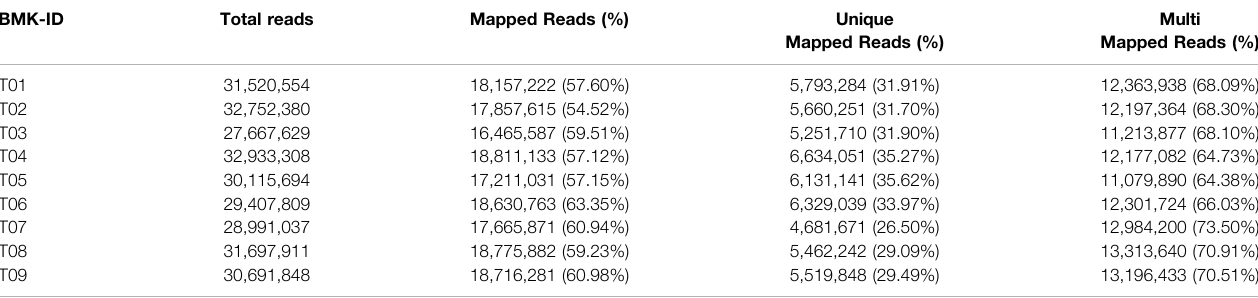
TABLE 3 | Comparison of results derived from second-generation sequencing vs. full-length transcripts. BMK-ID Total reads Mapped Reads (%) Unique